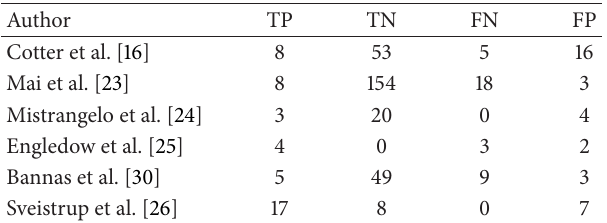
Table 3: Number of true-positive, true-negative, false-negative, and false-positive results of 6 studies collected on a per lesion-based